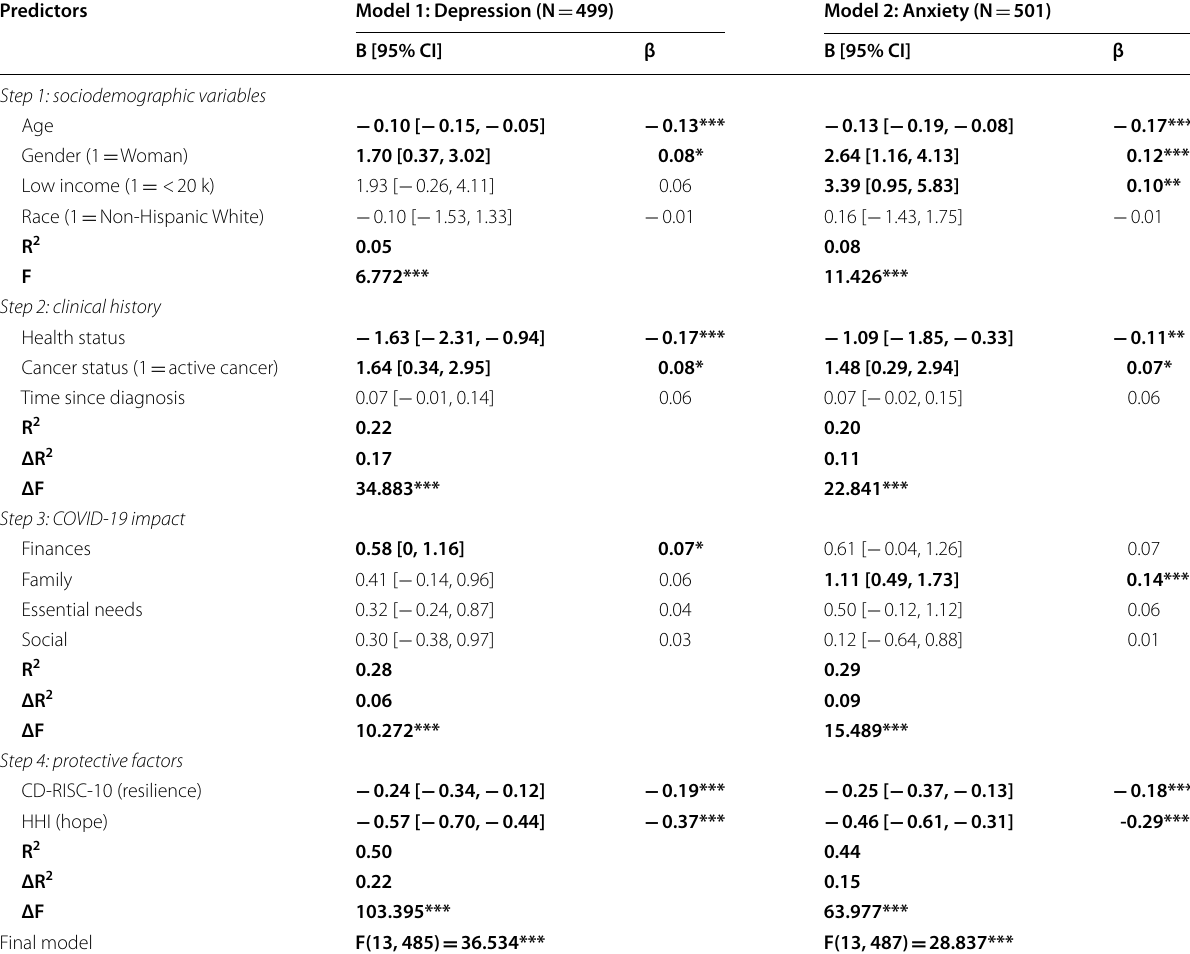
Table 4 Hierarchical regression results predicting Depression (Model 1) and Anxiety (Model